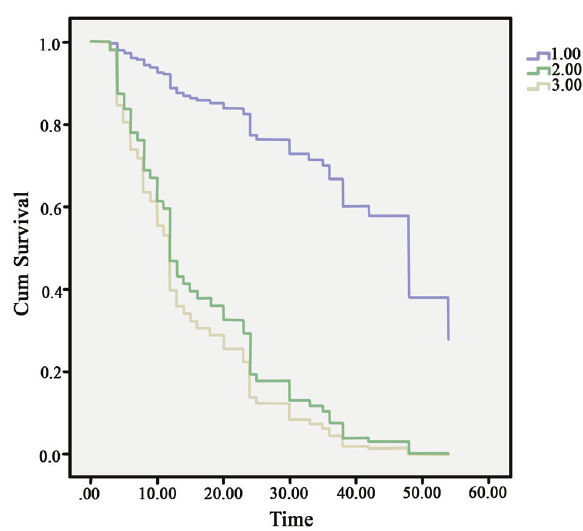
Figure 3 . Survival curve of patients according to versican expression of tumor cells. Significantly shorter survival was seen among patients whose gastric adenocar- cinoma expressed epithelial or stromal versican. P <0.001 [1.00: no versican expression 2.00: positive for epithelial versican expression 3.00: positive for epithelial versican